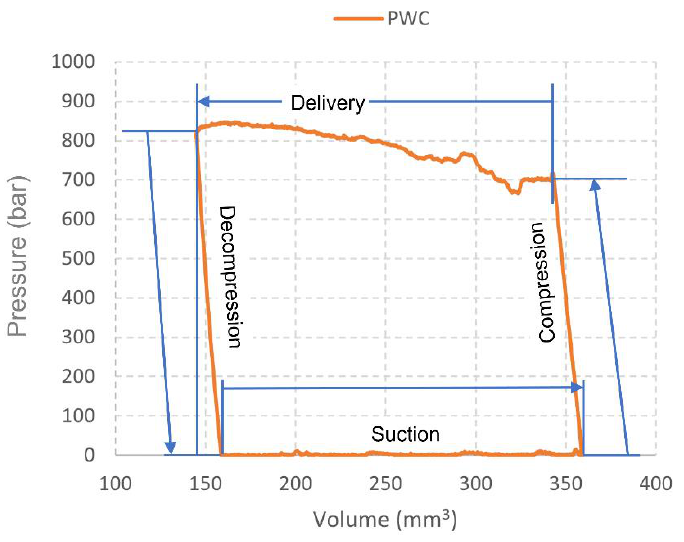
Figure 6. Pump indicator diagram–Low pressure, 1500 RPM, D100.